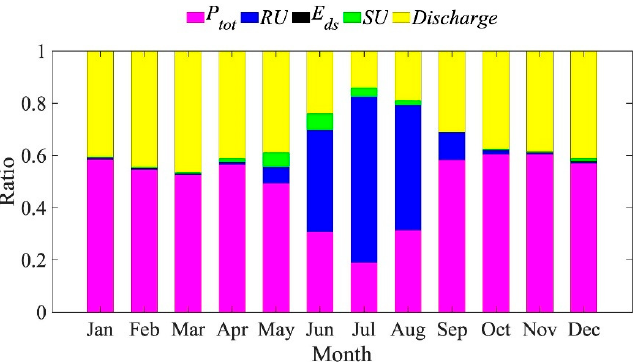
Figure 8. The contribution of factors including P tot , RU , SU , and E ds as well as ice discharge to monthly mass variations of the GrIS in each month during 2002–2020. The ratio was computed by absolute value of the mean of each factor at each month divided by the corresponding M tot